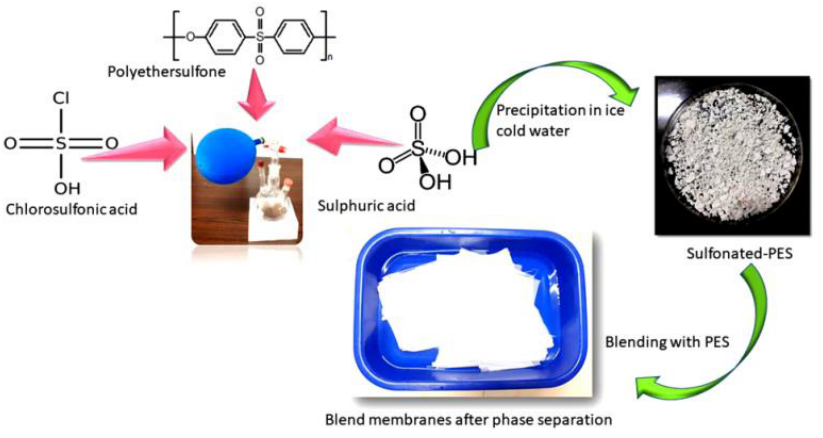
Figure 2. The synthetic procedure of SPES/PES blends membranes